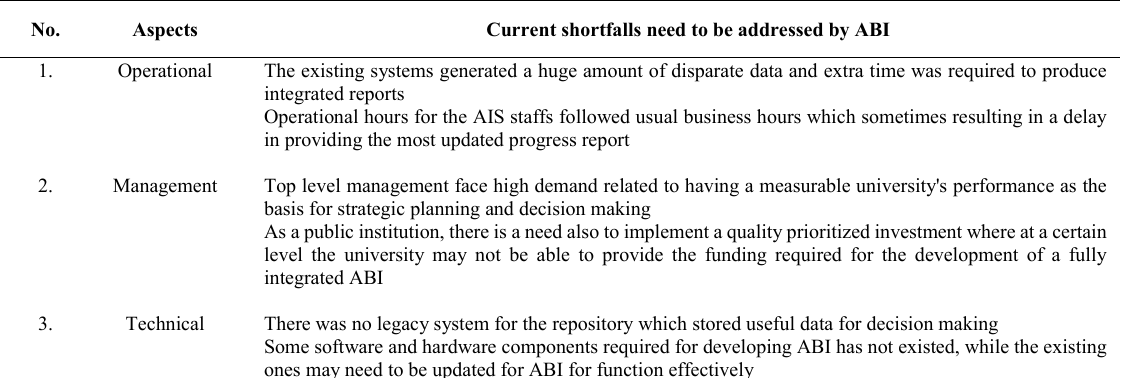
TABLE 1 K EY ISSUES IN THE CURRENT BUSINESS PROCESS OF THE U NIVERSITY XYZ